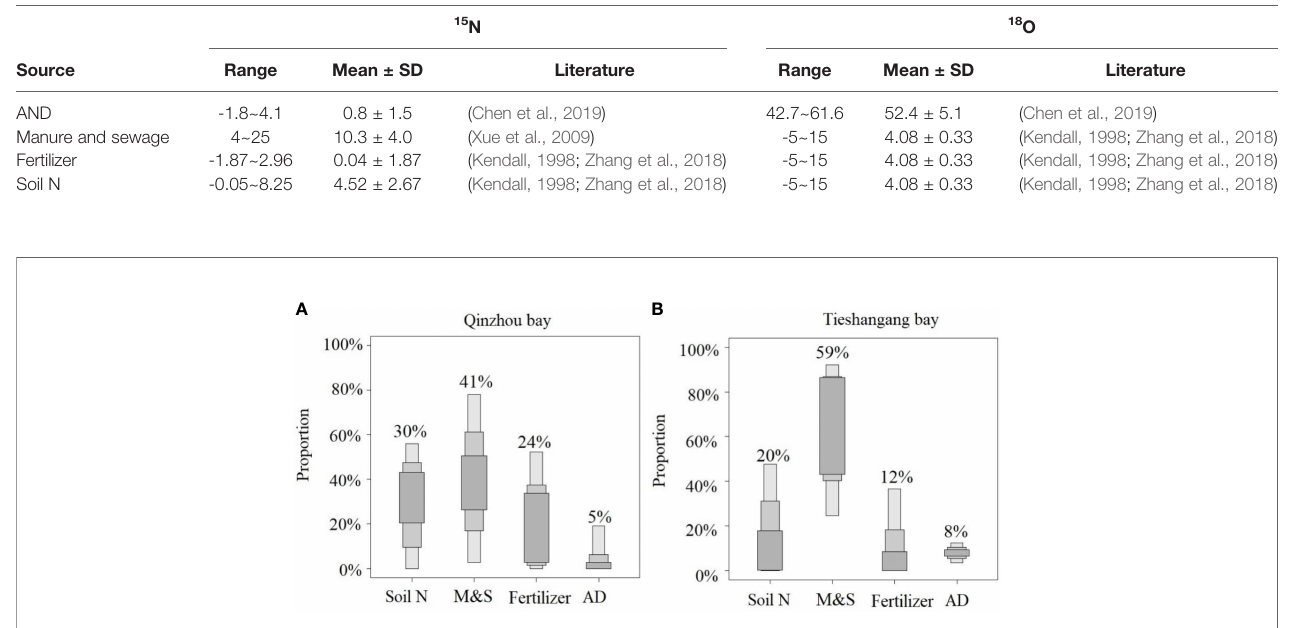
TABLE 2 | The values ( ‰ ) of dual isotopes for the four potential nitrate sources at the river mouth.